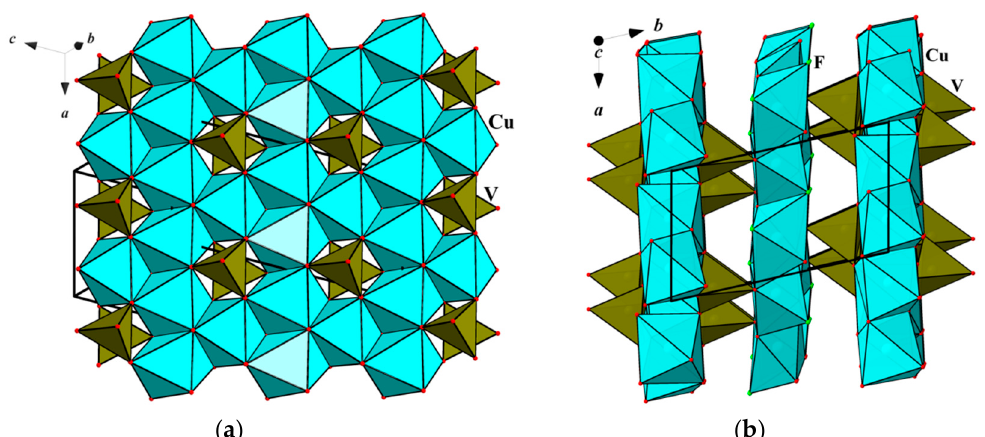
Figure 11. The {Cu 3 (OH) 2 [VO 4 ] 2 } 2- module in the crystal structure of Cu 13 (VO 4 ) 4 (OH) 10 F 4 ( a ) and its alternation with octahedral {Cu 3.5 (OH) 3 F 2 } 2+ layers in [001] projection ( b ).